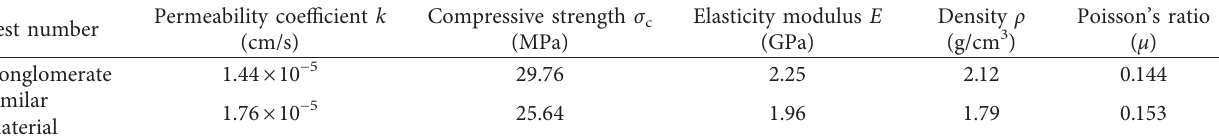
Table 8: Mechanical parameters of the nature and similar material